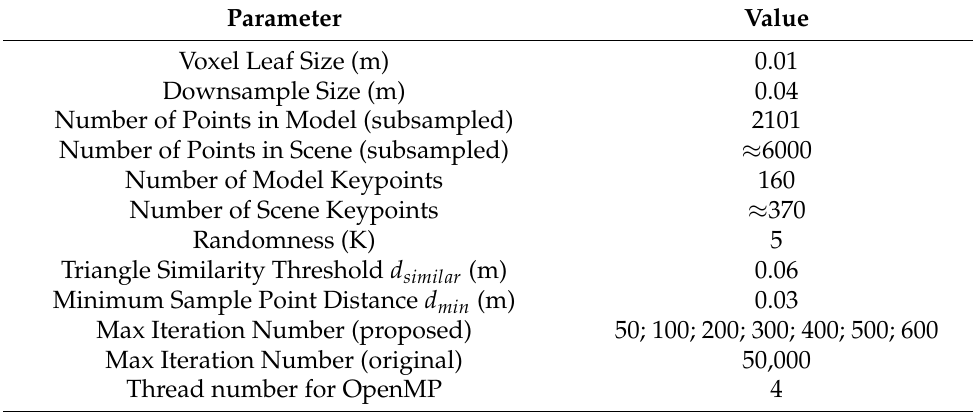
Figure 4. The object CAD model and recorded point cloud datasets. ( a ) The CAD model. ( b ) Point cloud model of the object; different pose with occlusion is shown in ( c , d ). Table 1. The used parameter values in the